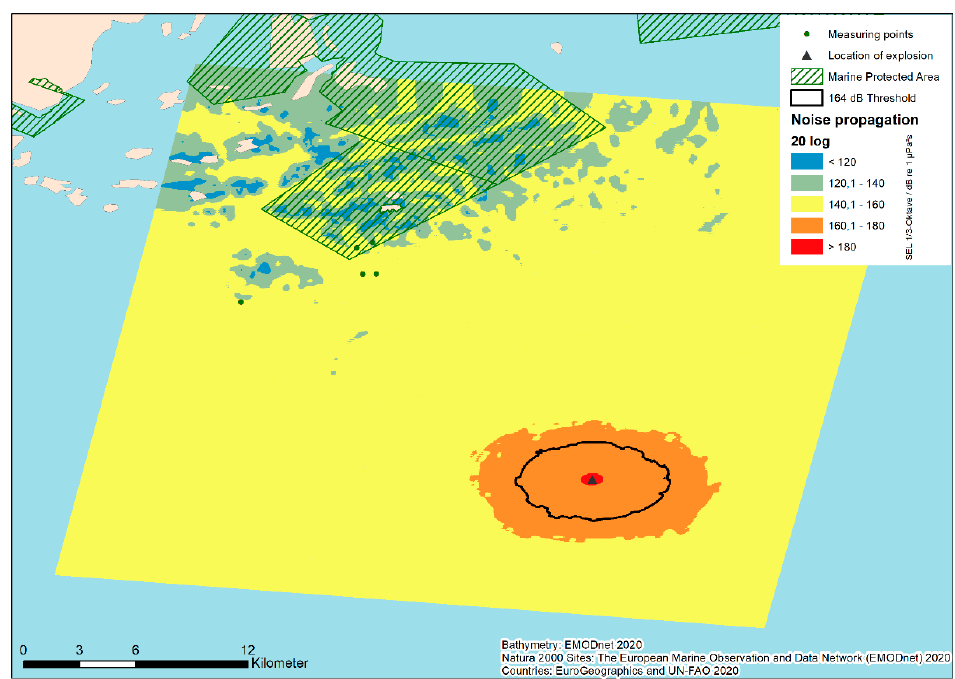
Figure A4. Sound exposure level map using 20 log law with consideration of the bathymetry.